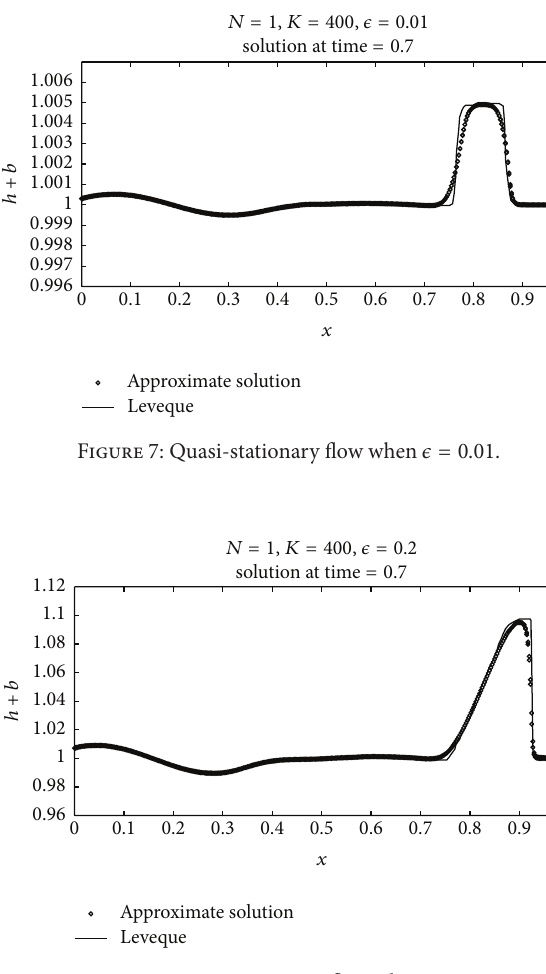
Figure 8: Quasi-stationary flow when 𝜖 = 0 .